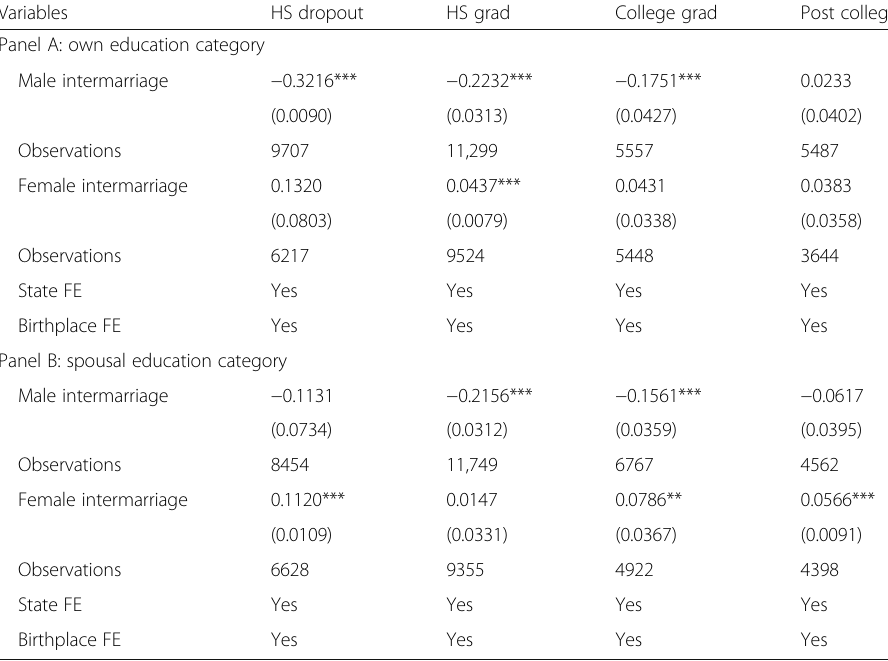
Table 4 Effects of intermarriage on household specialization: by education level Variables HS dropout HS grad College